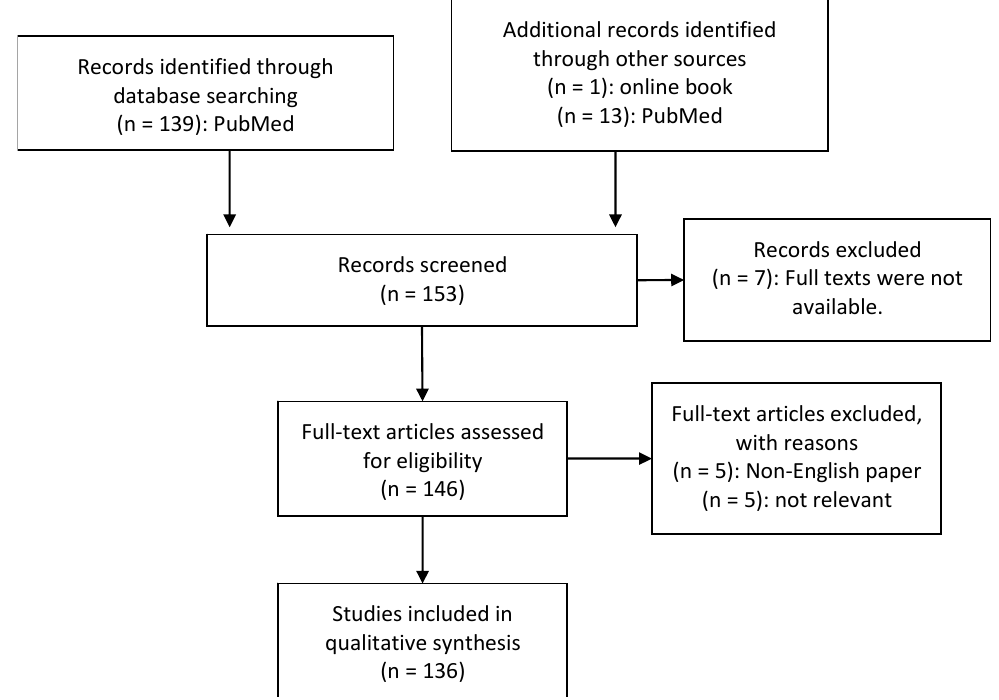
Figure 1. Methodical approach of this systematic review due to PRISMA criteria [39] .